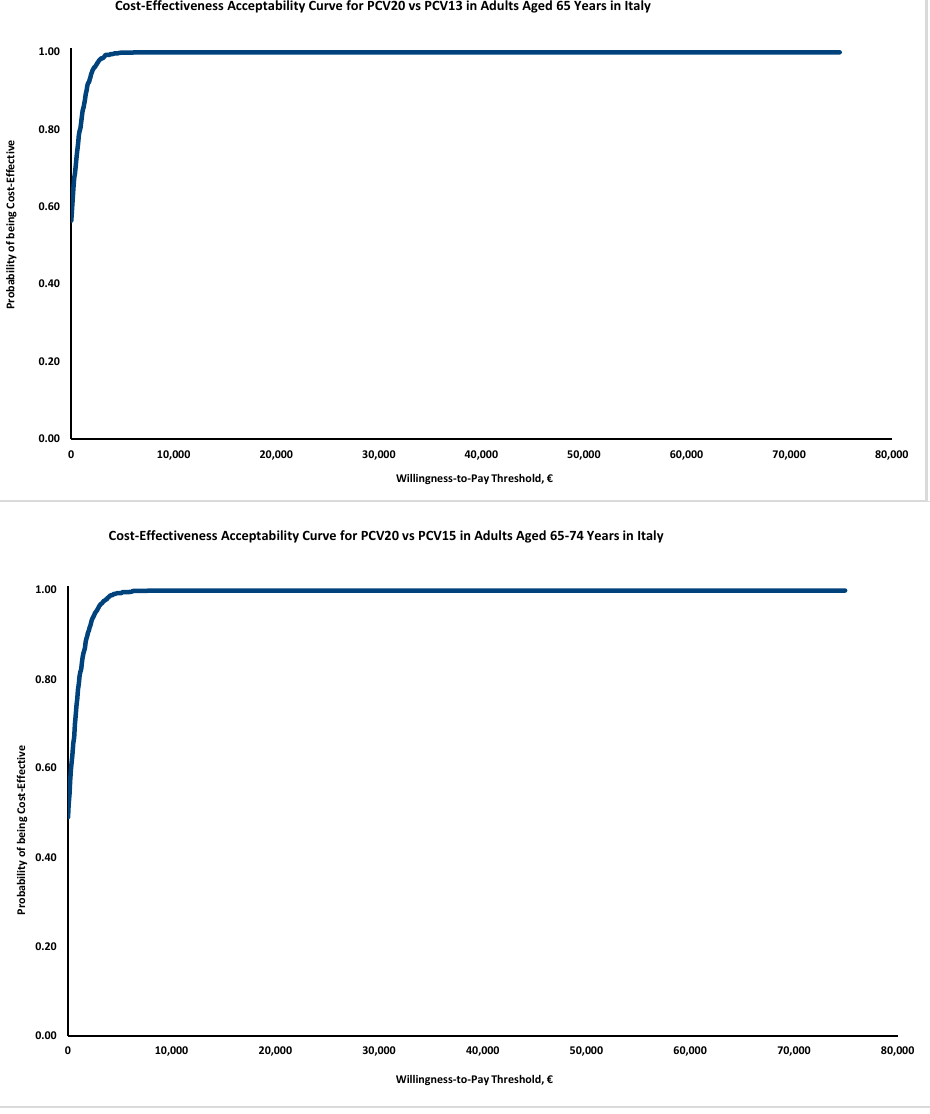
Figure 2. Cost-effectiveness acceptability curve.